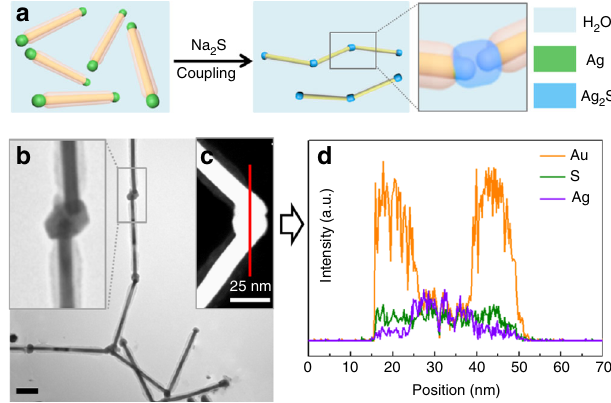
Fig. 6 Welding of AuNRs via Ag 2 S bridges. a Schematics illustrating the end-to-end welding of (AuNR- 1 )@PSPAA in colloidal solution. b TEM image of the welded AuNRs. c , d STEM image and EDX line scan for the welded junction. The scale bar is 100